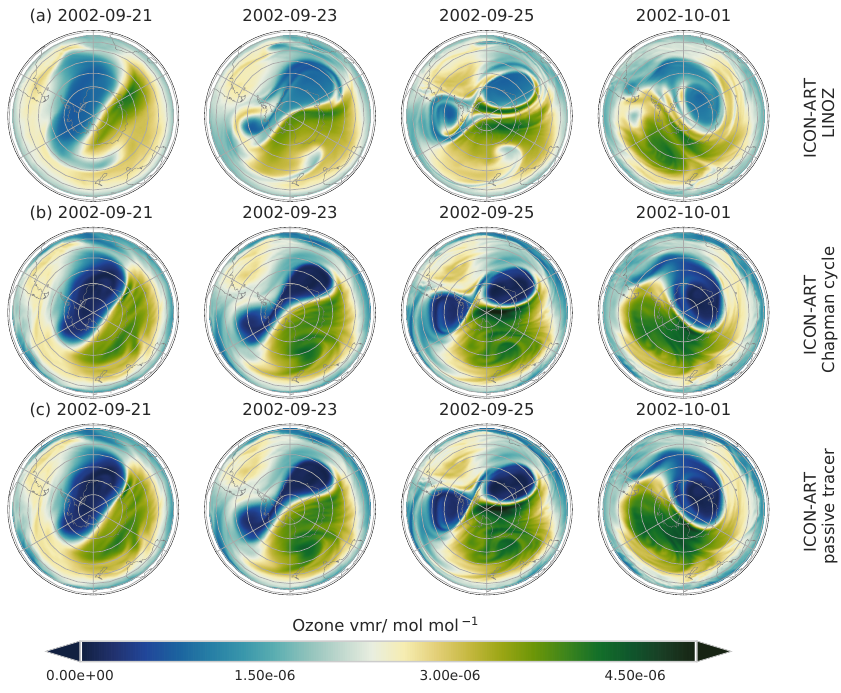
Figure 4. Passive and active ozone tracers (molmol − 1 ) at 50hPa over Antarctica. Daily averages for two ICON-ART simulations for the Linoz chemistry scheme (a) and for the extended Chapman cycle chemistry (b) and the passive tracer (c) are shown.